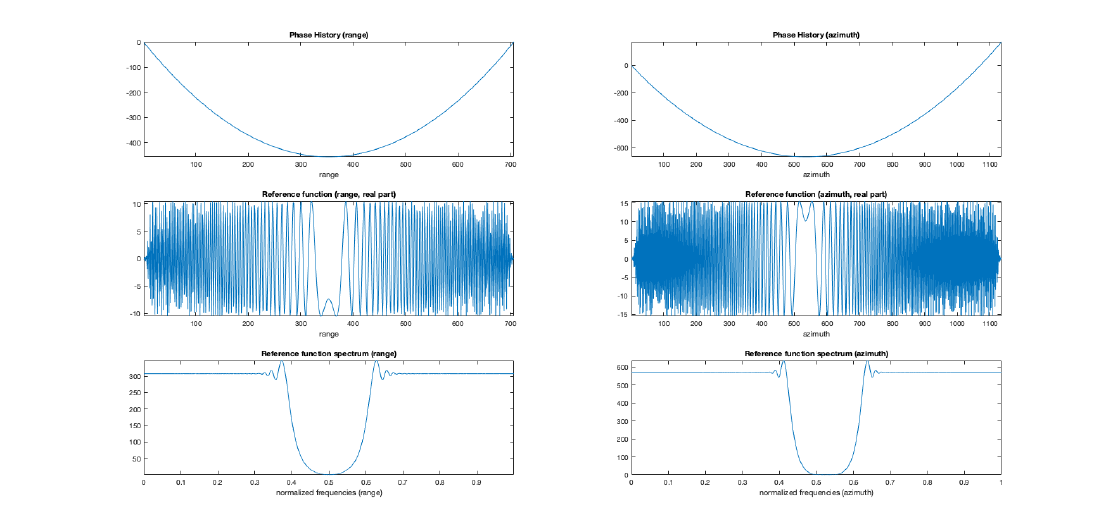
Figure 5. Range and Azimuth references to be used in the focusing procedure. Left range, right azimuth. The three rows present extracted phase histories, the real parts of the reference functions and their spectra.